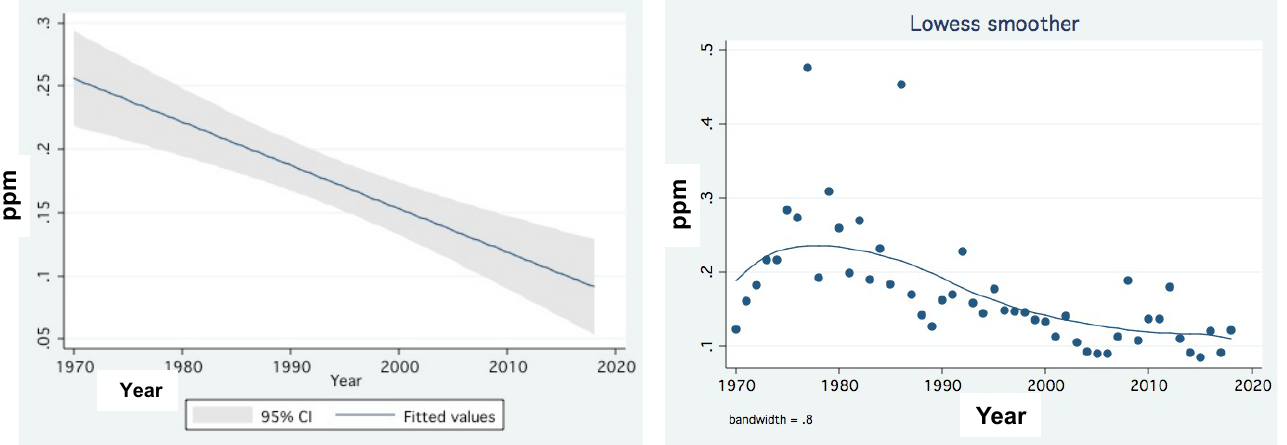
Figure 7. Temporal changes in climate conditions in the Kinneret watershed. Temporal (1970–2018) changes in annual average TP concentrations (ppm) in Jordan River water: linear prediction (95% CI) ( left ); trend of changes (LOWESS Smoother 0.8) ( right